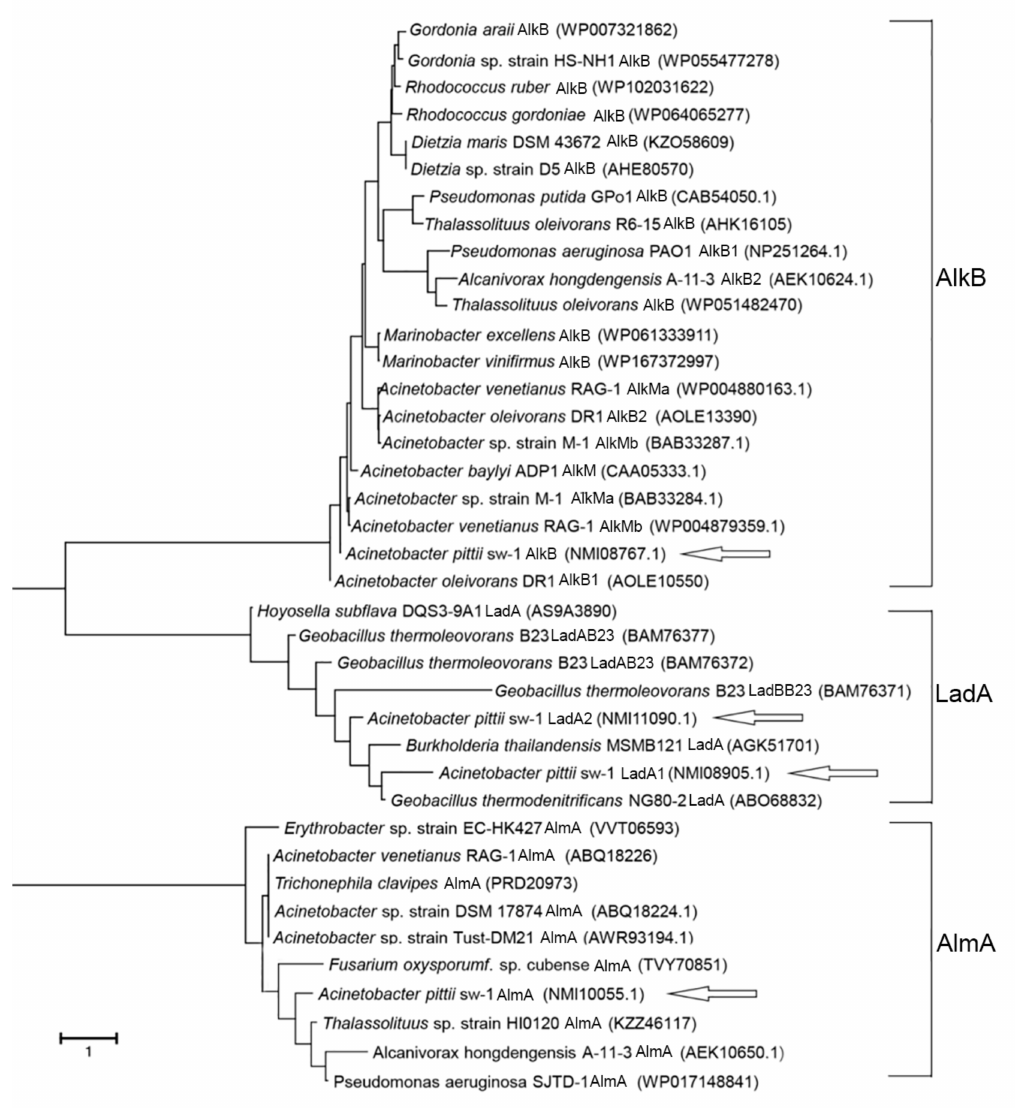
Figure 3. Phylogenetic analyses of AlkB, AlmA, LadA1, and LadA2 in A. pittii sw-1 compared with homologous proteins in other bacteria. Phylogenetic and molecular evolutionary analysis was conducted at a 1000 bootstrap value using the MEGA software. Data on the sequences of other genes were downloaded from